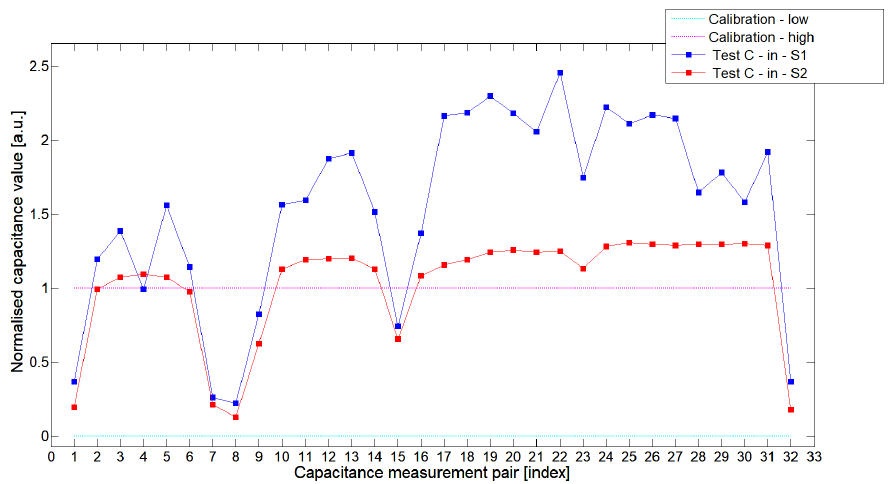
Figure 12. The 1st electrode measurement cycle (S1: 1->32 and S2: 1->32) for Test C in and S1—blue line, S2—red line. Cyan and magenta lines indicate calibration limits (0;1).